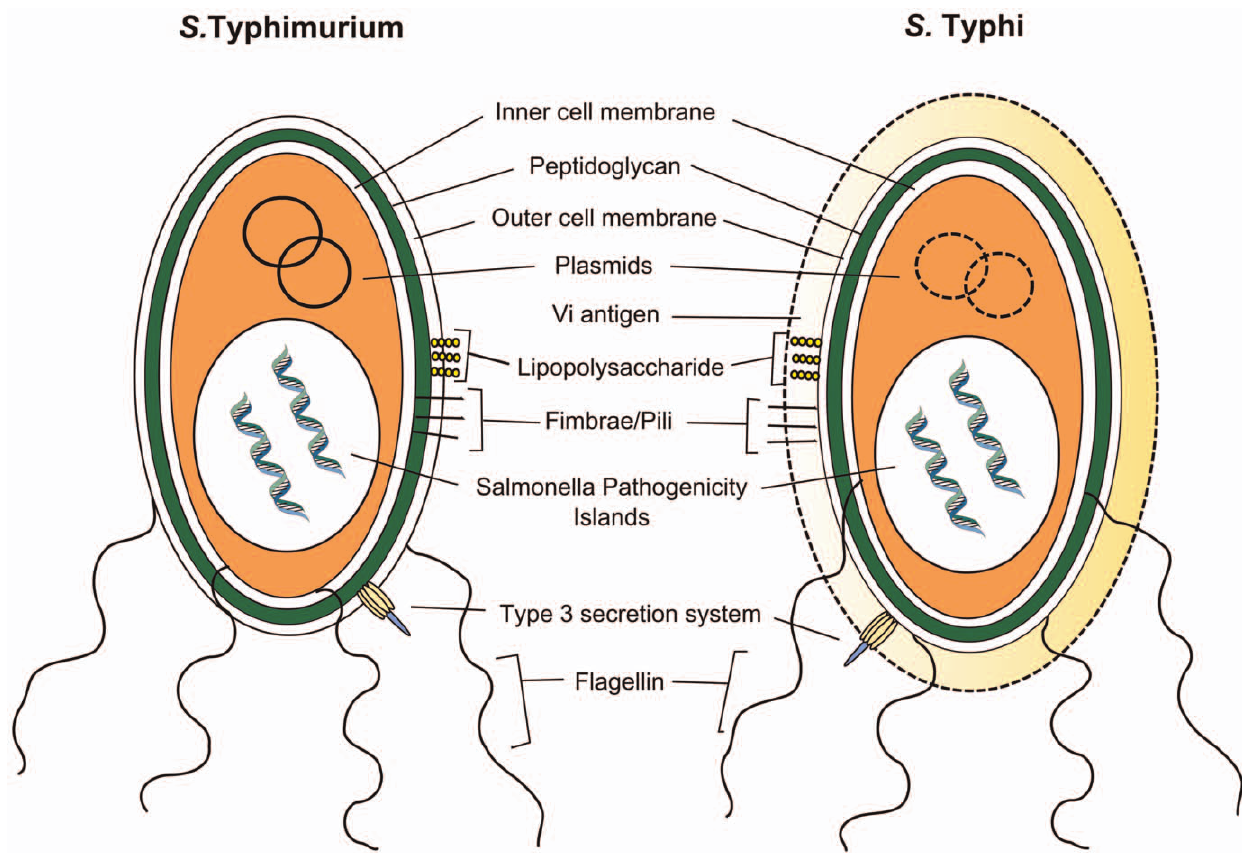
Figure 2. Virulence of S. Typhimurium and S. Typhi. S. Typhimurium and S. Typhi possess partly overlapping and a partly distinct repertoire of virulence factors. Both serovars express the type III secretion system, lipopolysaccharide, and other surface polysaccharides, fimbrae, flagellin, and bacterial DNA. The Vi antigen is exclusively expressed by S. Typhi and is able to circumvent the innate immune response by repressing flagellin and LPS expression. S PI, Salmonella pathogenicity islands.